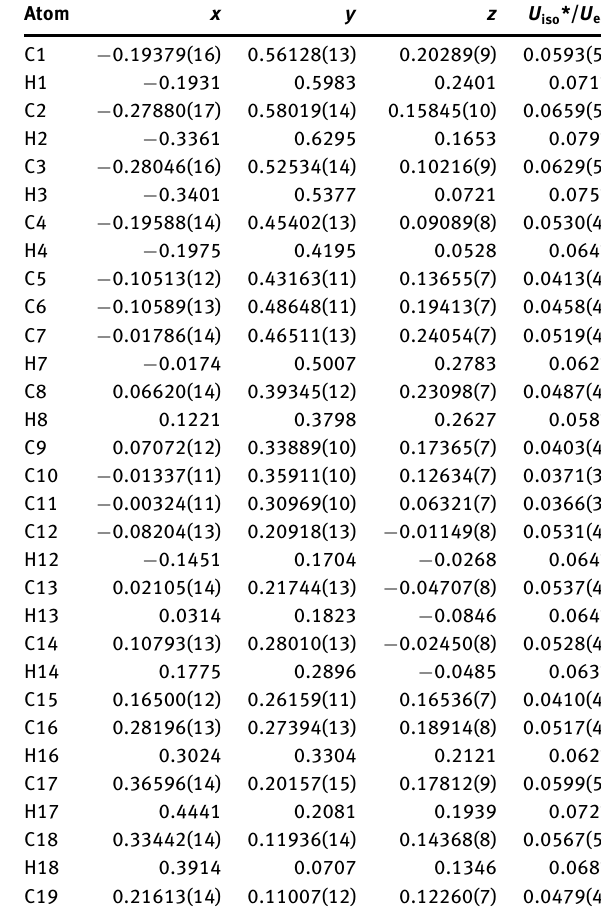
Table 2: Fractional atomic coordinates and isotropic or